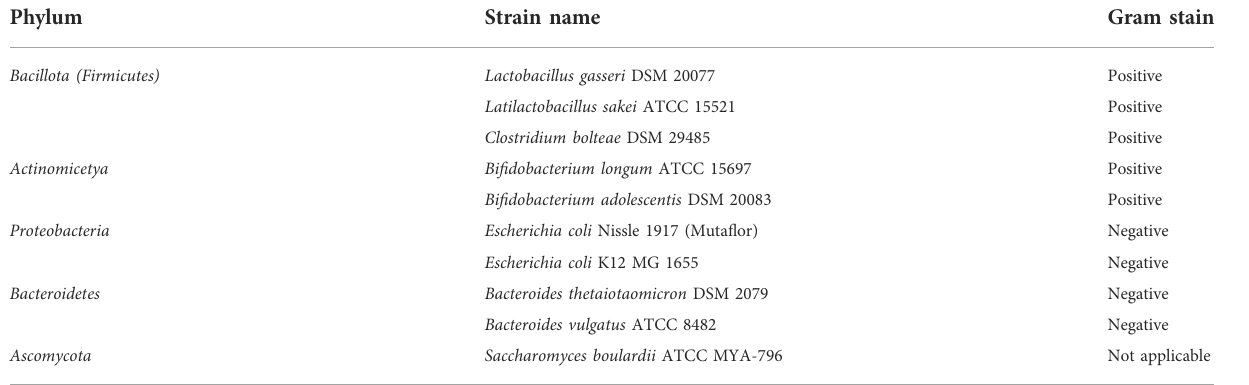
TABLE 2 List of the different gut commensal strains used in this